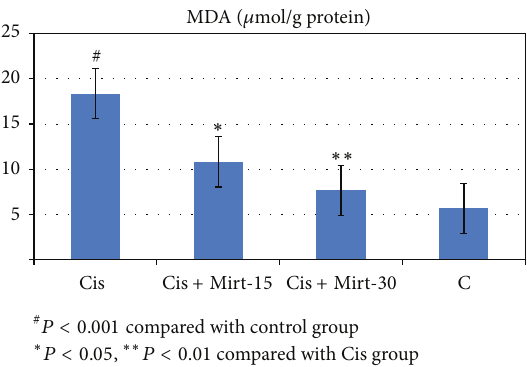
Figure 1: MDA levels of study groups.